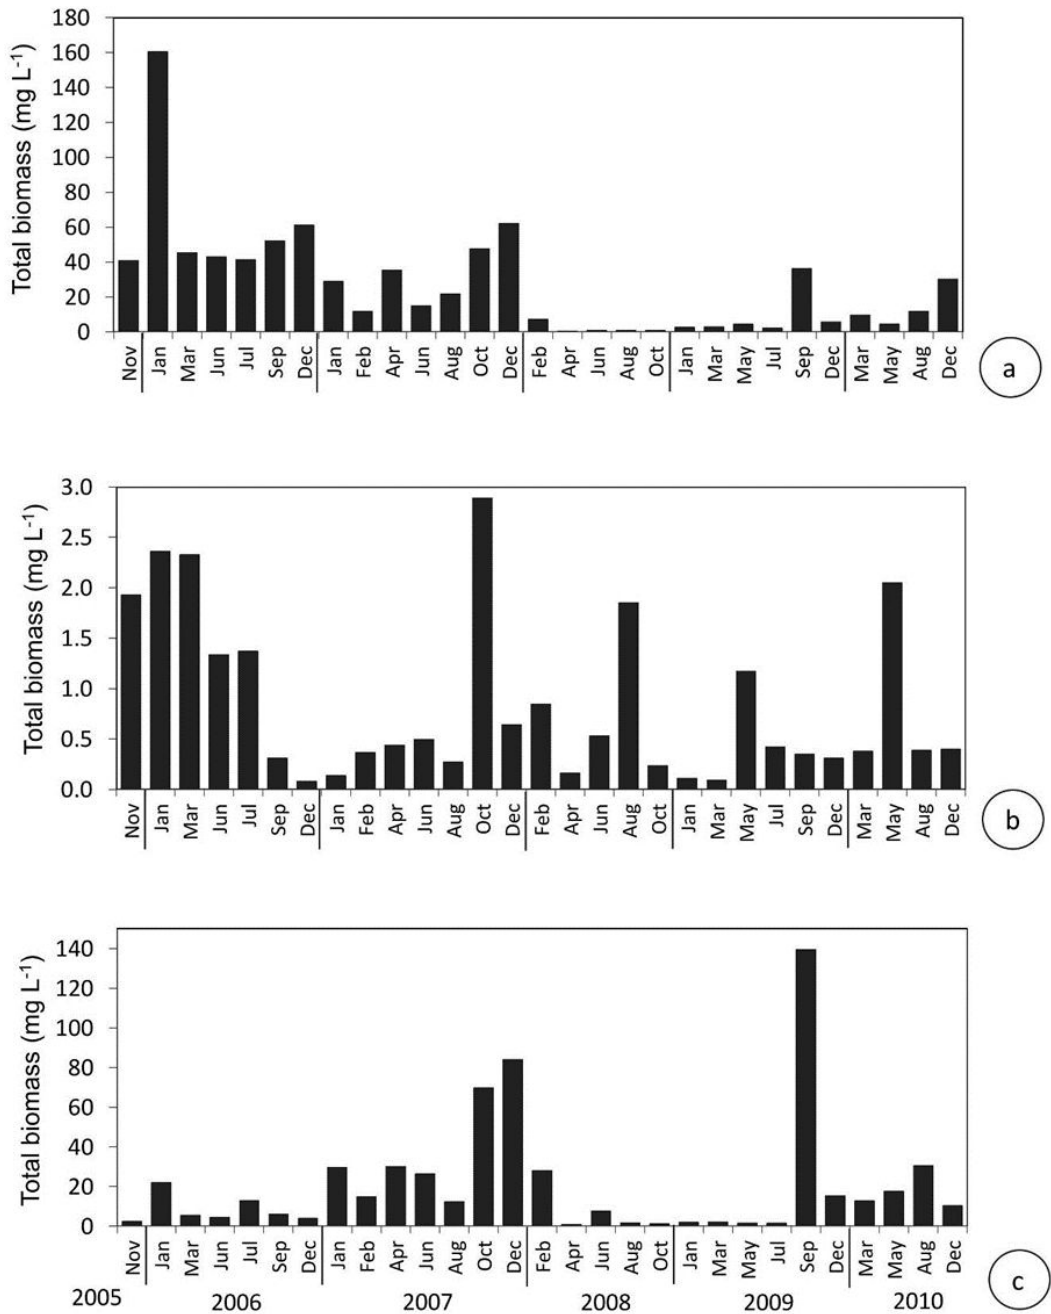
Figure 4. Absolute biomass of the phytoplankton community in Soledade (a) and Taperoá (b) reservoirs and Panati lagoon (c) from November 2015 to December